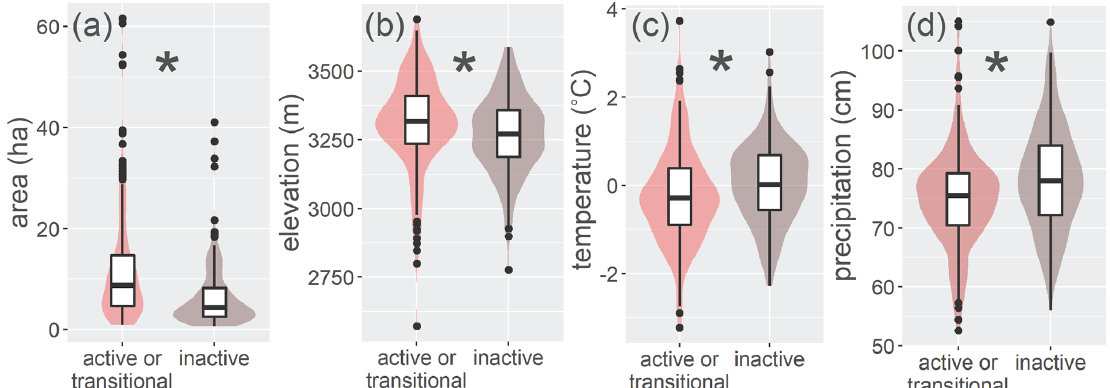
Figure 6. Violin plots comparing active rock glaciers with inactive rock glaciers from the previous Uinta rock glacier inventory. Asterisks denote statistically significant differences, and n = 404.